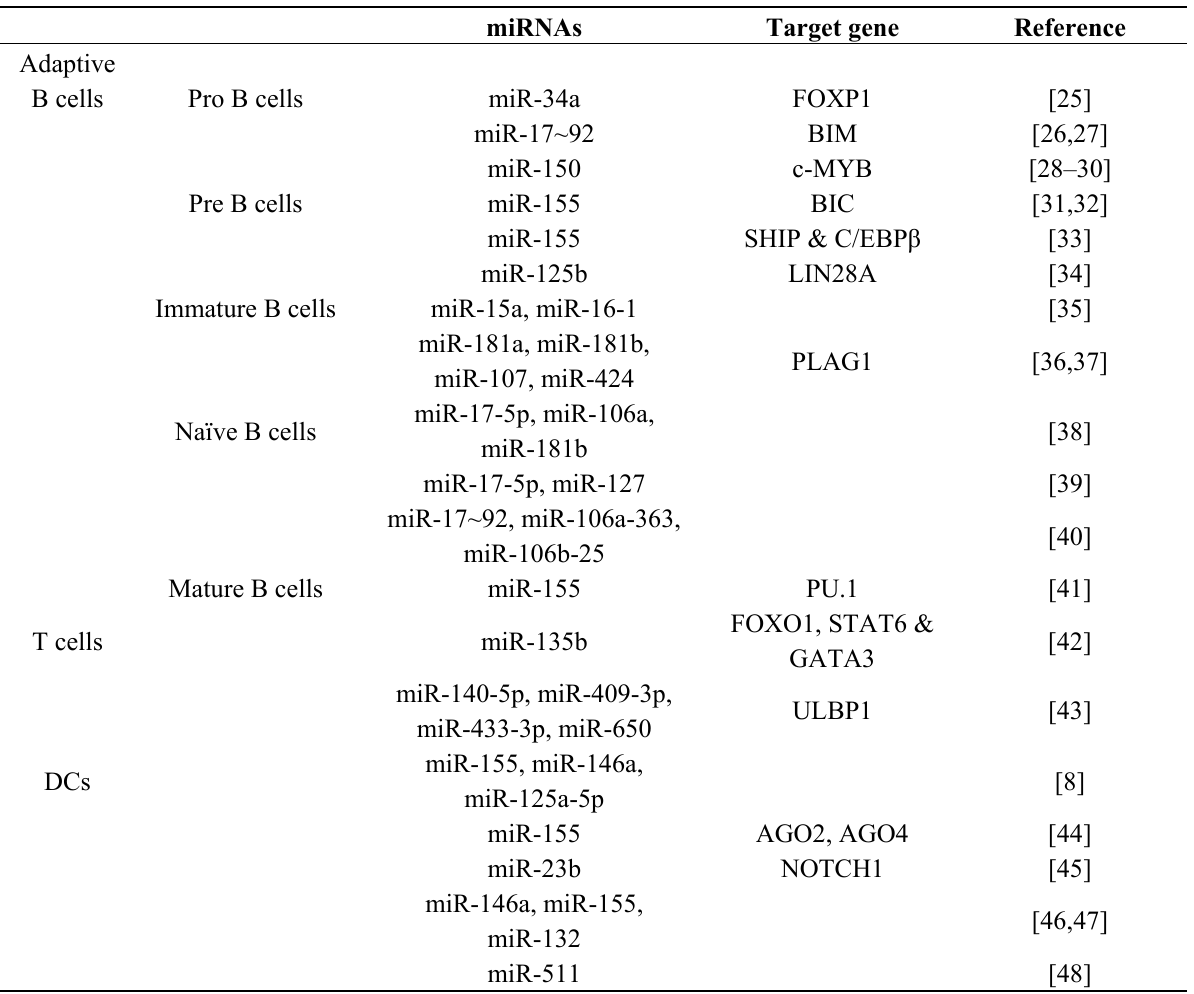
Table 2. miRNAs involved in adaptive